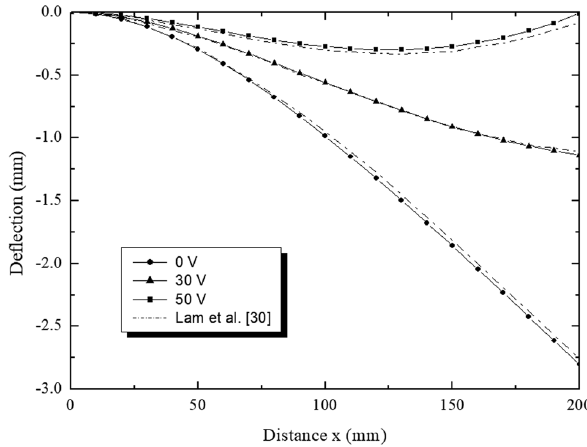
Figure 4: The centerline de fl ection under uniform load and di ff erent actuator ’ s input voltage.